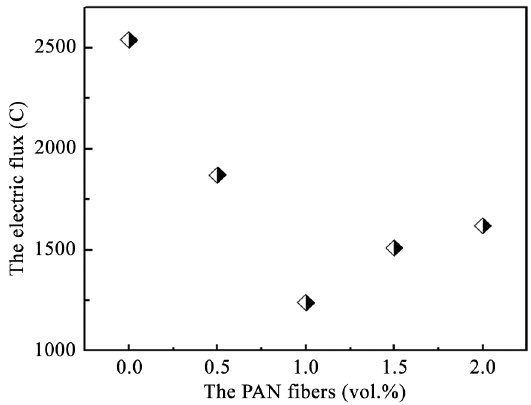
Figure 2. Chloride penetration resistance performance of PAN fiber reinforced